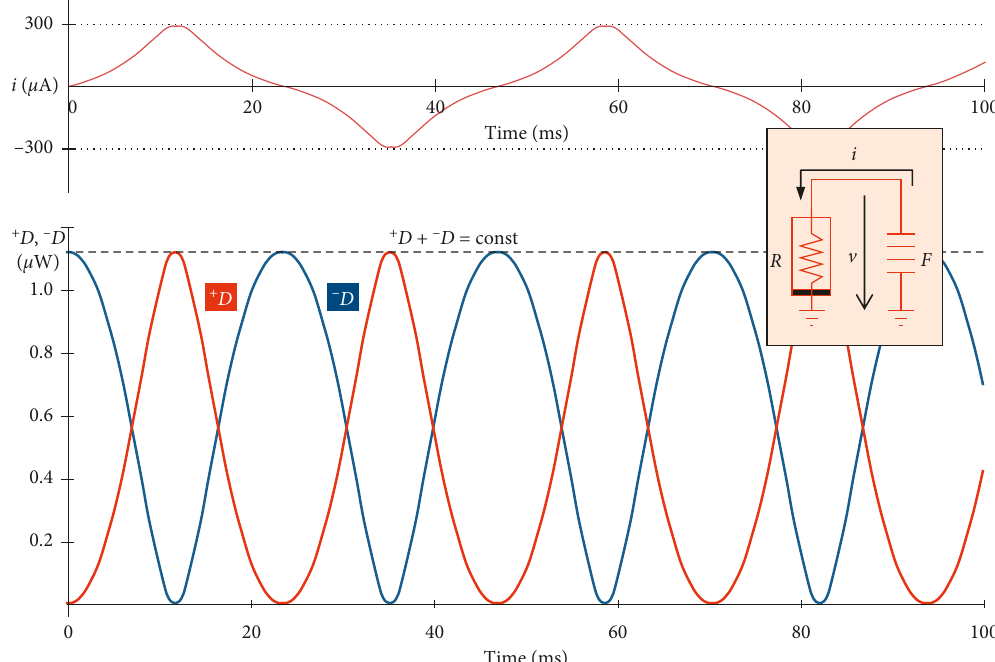
Figure 4: Analysis of the oscillator formed from a nonlinear resistor and a linear FDNR with the constitutive relations (18), a � 10m Ω , b � 100 µ A, and c � 1 M Ω s − 2 . The waveforms of current (at the top) and dissipative function + D of nonlinear resistor (6) and − D of FDNR, the latter being equal (due to element linearity) to the dissipative cofunction − D ∗ (8). The sum + D + − D is constant. It is in accordance with the content conservation law